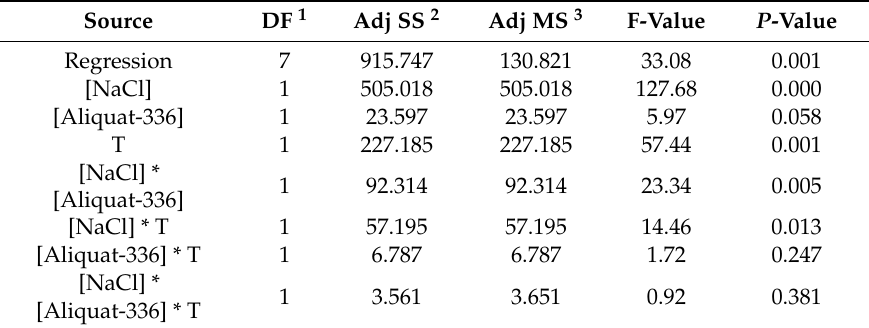
Table 9. Analysis of